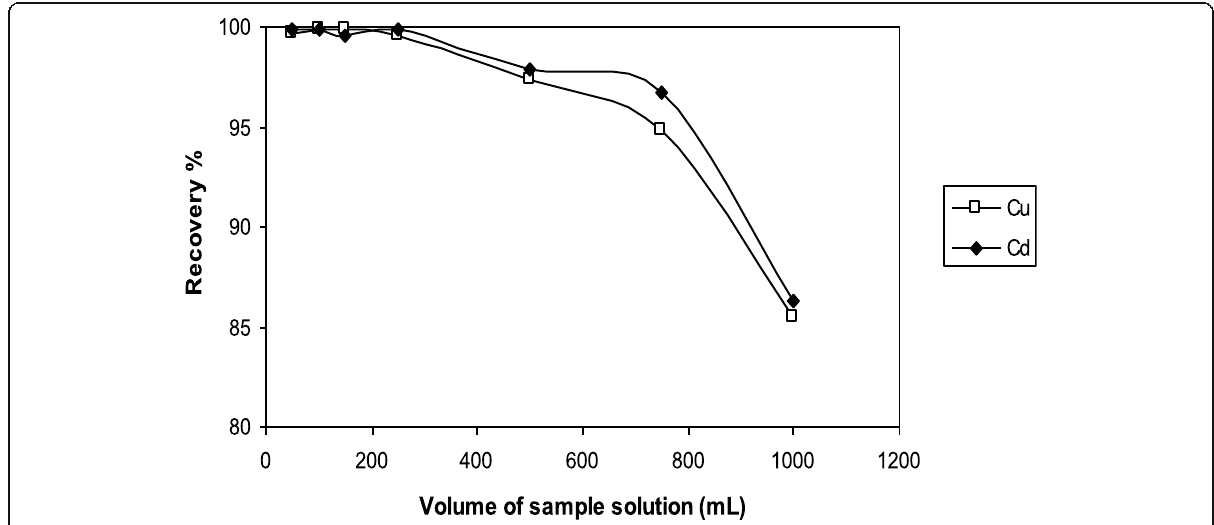
Fig. 4 Effect of sample volume on the recovery of Cu(II) and Cd(II) by Phanerochaete chrysosporium immobilized on bentonite